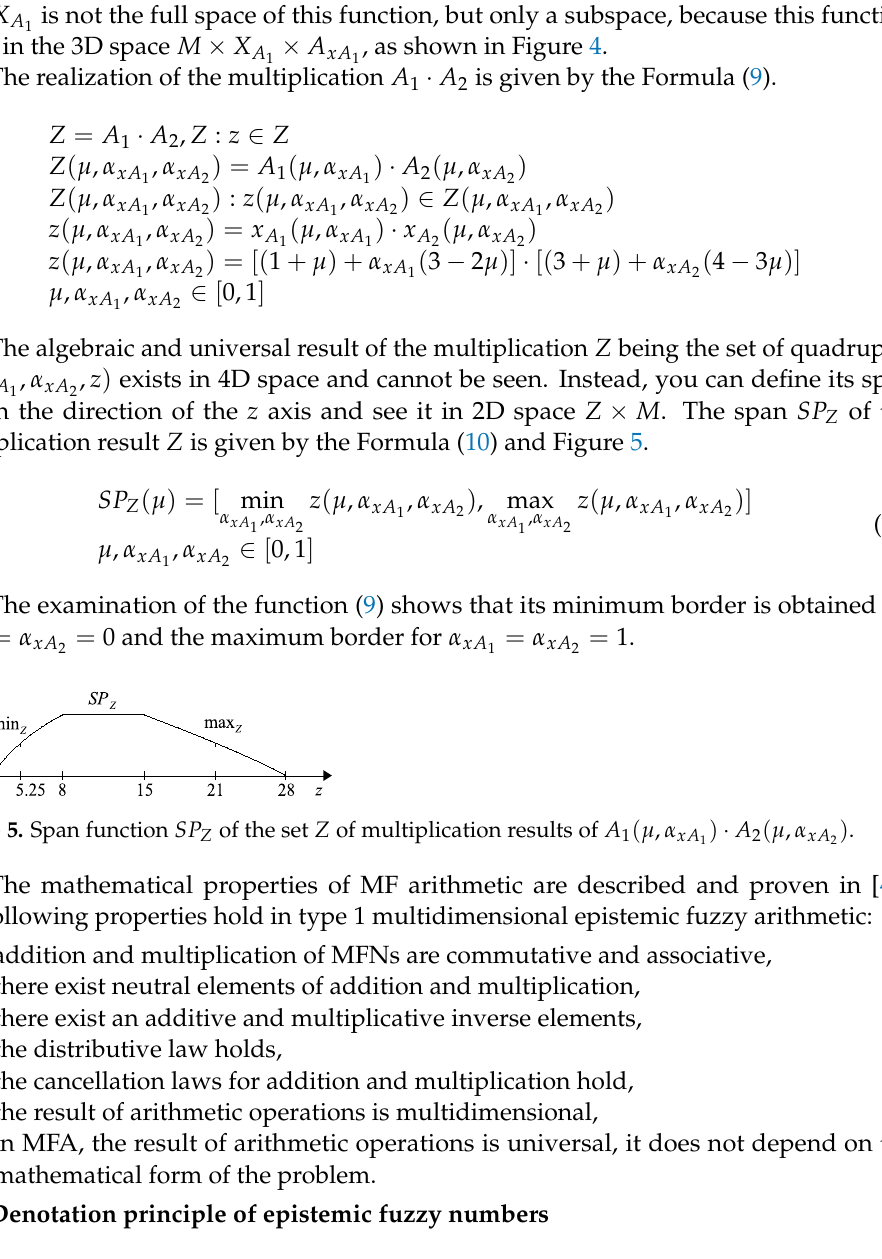
Figure 5. Span function SP Z of the set Z of multiplication results of A 1 ( µ , α xA The mathematical properties of MF arithmetic are described and proven in